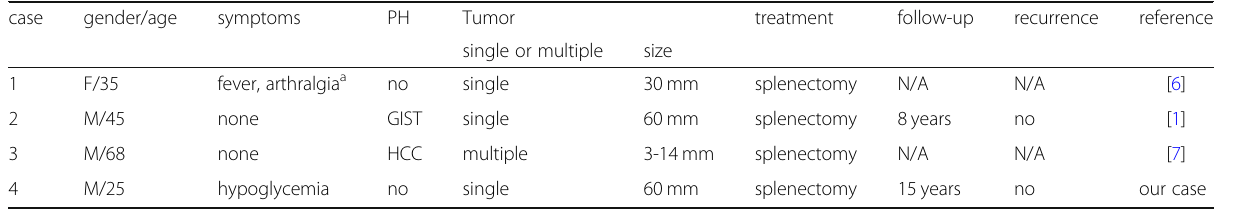
Table 1 Clinical features of four cases of splenic cord capillary hemangioma